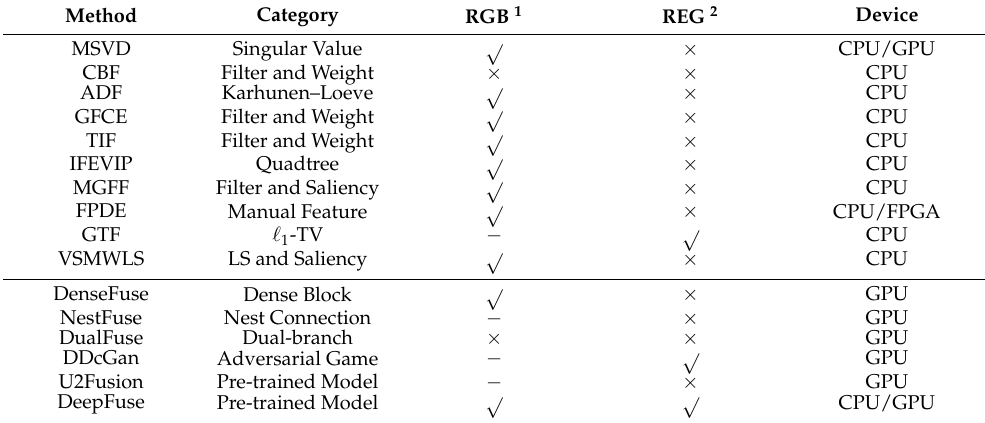
Table 1. Summary of fusion